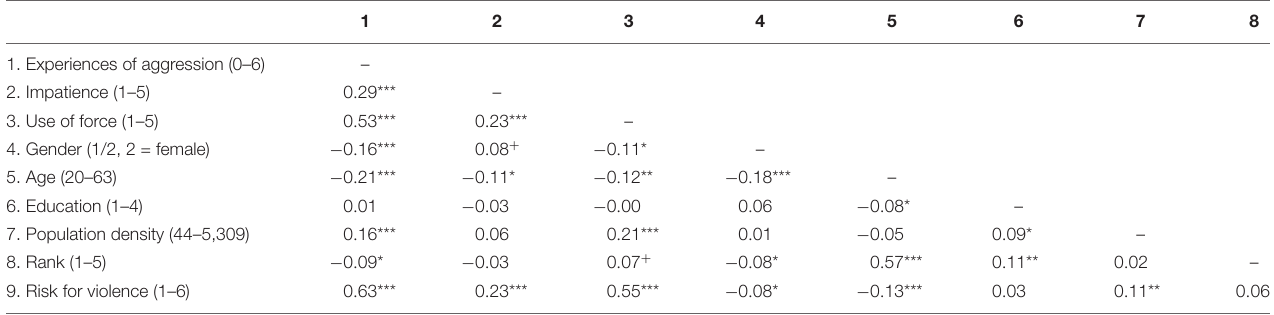
TABLE 2 | Bivariate correlations of dichotomous, ordinal and interval variables T1, based on pooled results using multiple imputation ( N = 693) a .